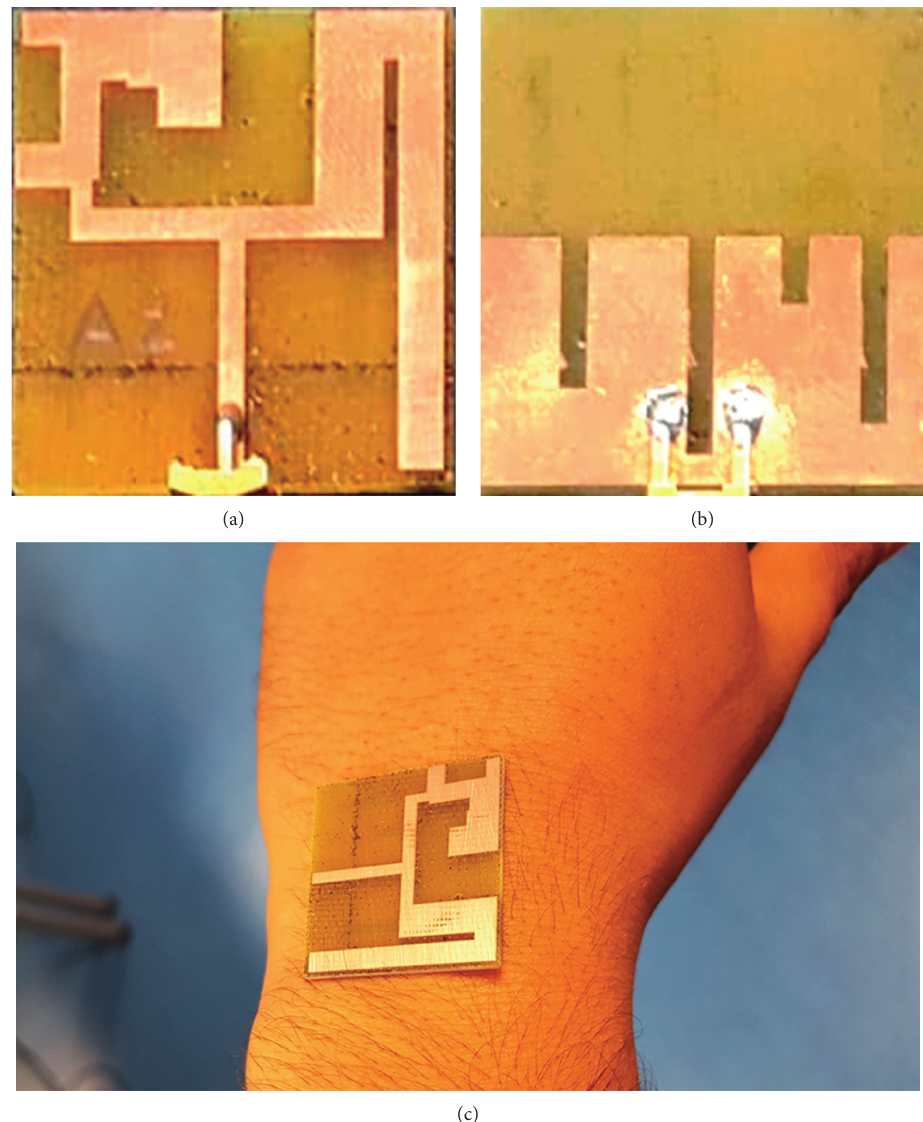
Figure 5: Manufactured antenna design.